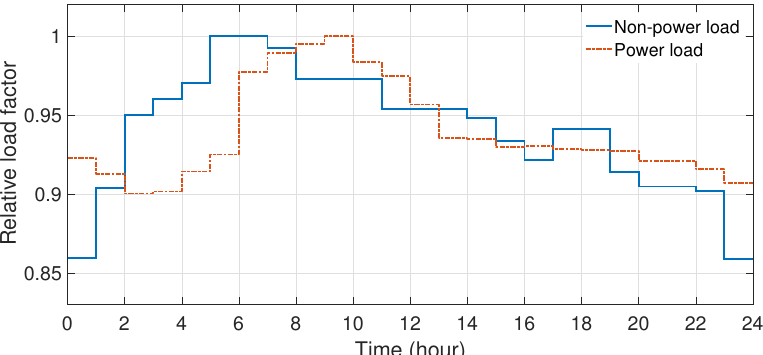
Figure 4. Load profiles of gas consumption relative to maximum demand in power plant and other